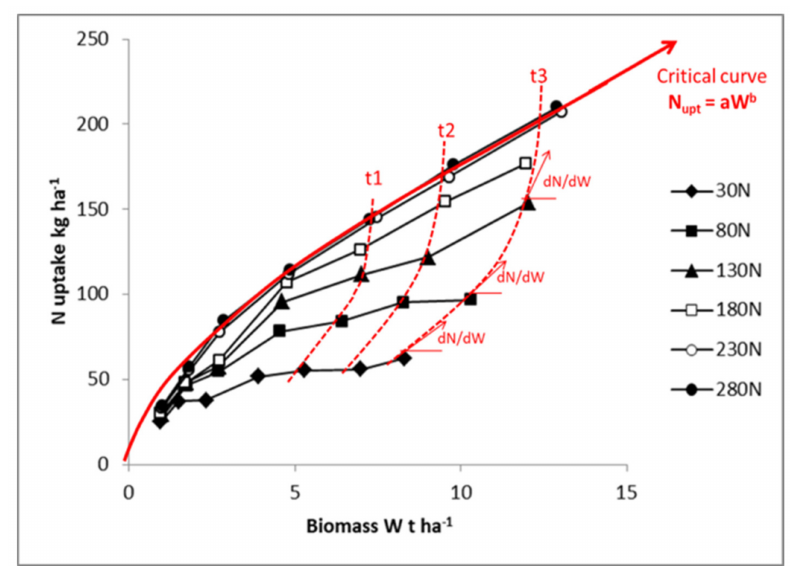
Figure 2. Plant N uptake relationship with relative crop biomass for maize crops receiving di ff erent N fertilizer application rates (from 30 to 280 kg N · ha − 1 ). The red full line represents the critical N uptake curve for maize (N c = 34W c0.64 ). The dotted lines denote the inverse of the response of W to N uptake at di ff erent time (t1, t2, t3, ... ), and dN / dW represents the inverse of N conversion e ffi ciency. Di ff erent symbols represent the N fertilizer application rates. Data redrawn from Pl é net and Lemaire [22].